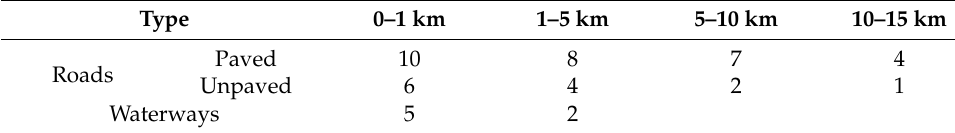
Table 2. Human influence scores for roads and